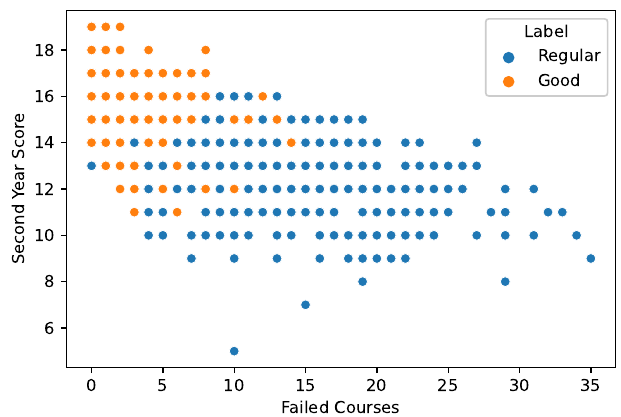
Figure 9. Scatter plot showing relationship between Failed Courses and Second Year Score; the colors that represent each value of the target indicate that they are linearly